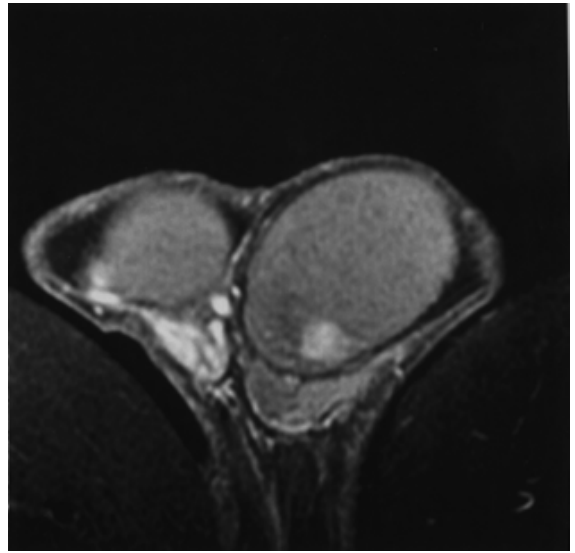
FIGURE 2B. There is enhancement greater than the surrounding parenchyma on T1-weighted images post gadolinium-DTPA administration.